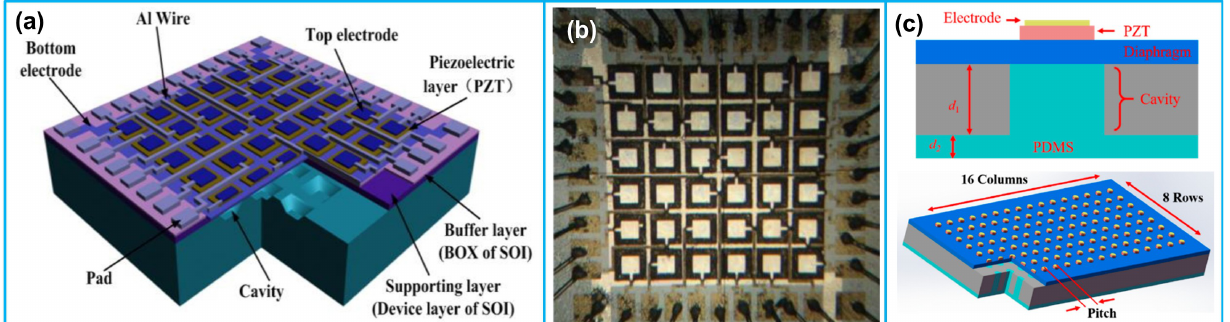
Figure 7. ( a , b ) A photograph image of the 6 × 6 PMUT array with element size 200 µ m × 200 µ m; ( c ) schematic of the PMUT with PDMS backing structure. ( a , b ) Reprinted from Ref. [125] with permission; ( c ) reprinted from Ref. [128] with